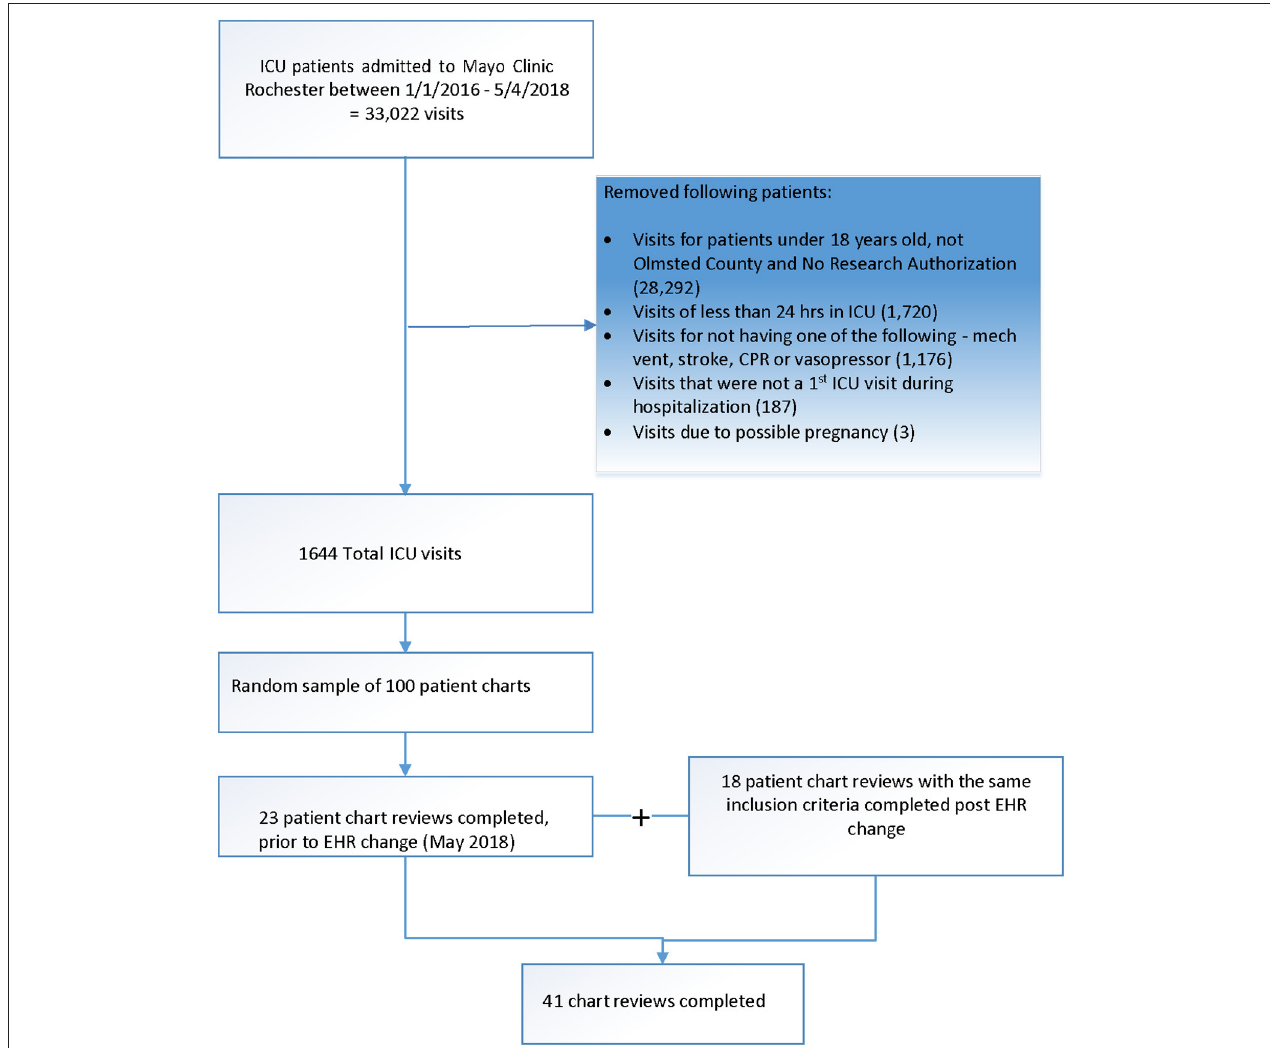
FIGURE 1 | Consort diagram of patient chart